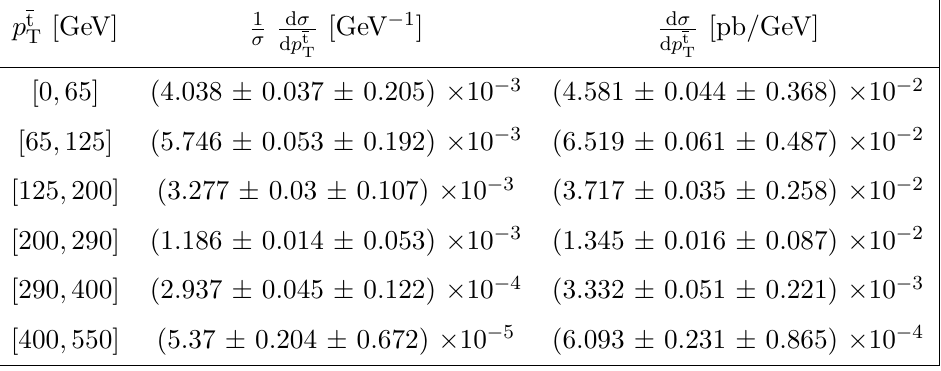
Table 16 . The measured di(cid:11)erential cross section and bin boundaries for each bin of the normalized and absolute measurements of the tt di(cid:11)erential cross section at particle level in the (cid:12)ducial phase space as a function of p t are tabulated. T